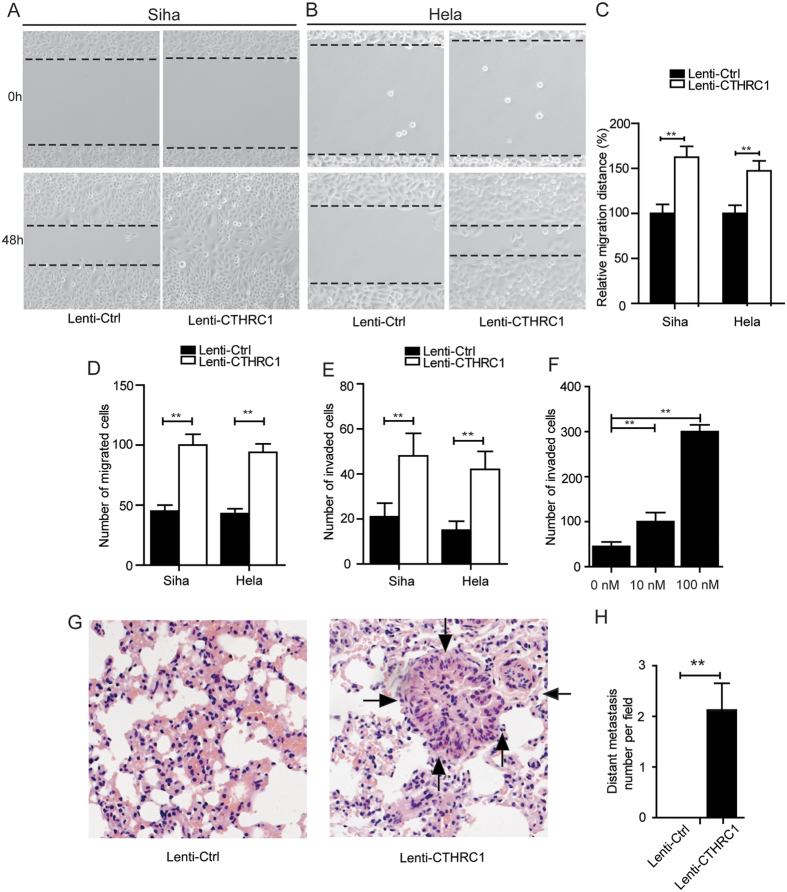
CTHRC1 can promote cervical cancer migration and invasion in vitro.(A and B) Representative wound healing images of Siha (A) and Hela (B) at 0 and 48 h, respectively. The black line outlined the cell boundary. (C) Quantification of wound healing rates was analyzed in Siha and Hela cells respectively. Data are means ± SD of the wound area relative to the control group, n = 3. (D) Quantification of migrated rates was analyzed in Siha and Hela cells respectively. (E) Quantification of invaded rates was analyzed in Siha and Hela cells respectively. (F) Statistical analysis of the cell migrated stimulated by rCTHRC1 protein. (G) Pulmonary metastases were detected by H&E staining. (H) Statistical analysis of numbers of pulmonary metastatic nodules, n = 3. Original magnification: 200 × . Quantification of cells on the lower surface of the membrane were performed with three randomly selected fields and shown on the right panels. Data are means ± SD. *P < 0.05, **P < 0.01.